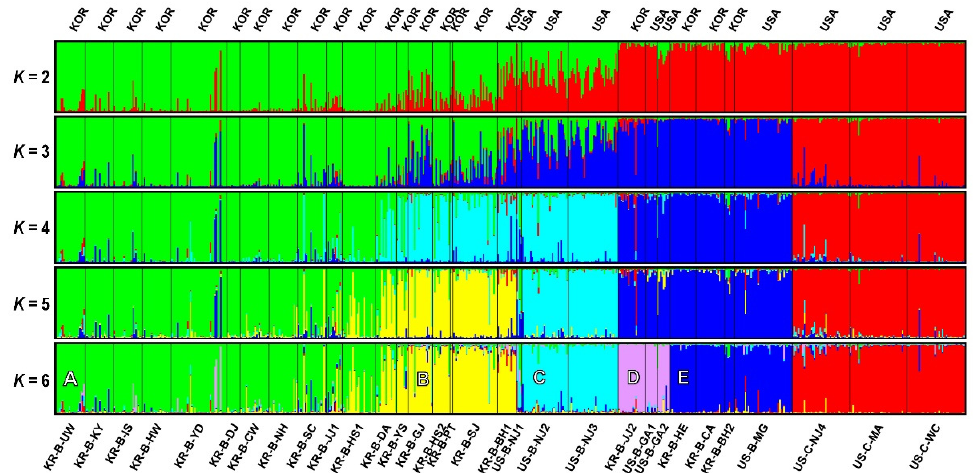
Figure 4. Bayesian clustering (STRUCTURE) for the 31 Dasineura oxycoccana populations collected from blueberry and cranberry in the USA and Korea. Individual assignment plots for K = 2, 3, 4, 5, and 6. Different colors indicate different clusters (e.g., A–E).